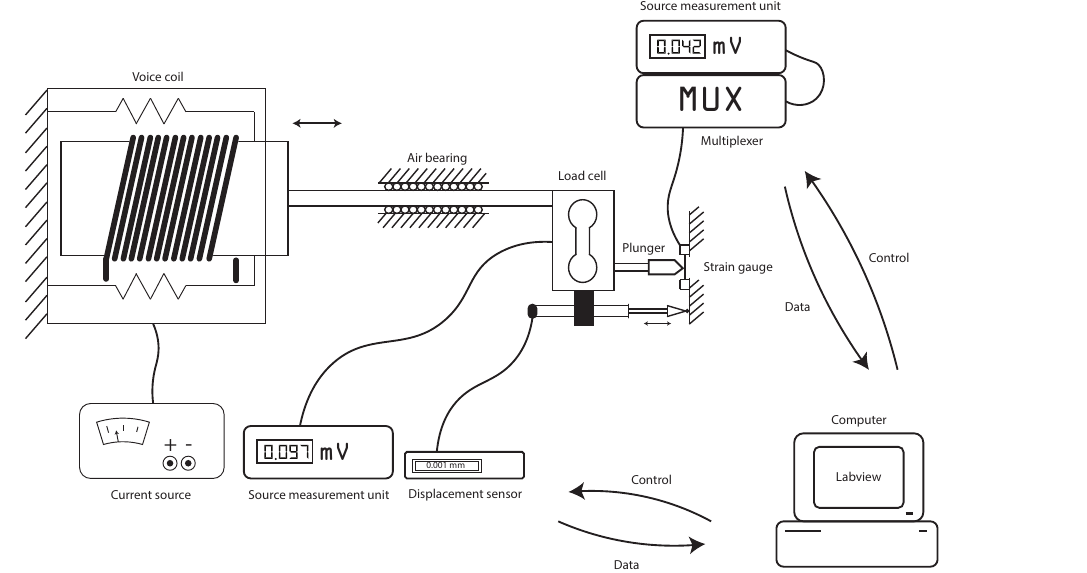
Figure 9. Measurement set-up to analyse the response of the strain gauges. A voice coil actuator is connected to a load cell via a rod which slides over an air bearing. On the other side of the load cell a plunger is connected which is pushed on the strain gauge. The system is set to a certain force after which the resistance of the 10 channels, the load cell and the displacement sensor are read out (Welleweerd, 2017).